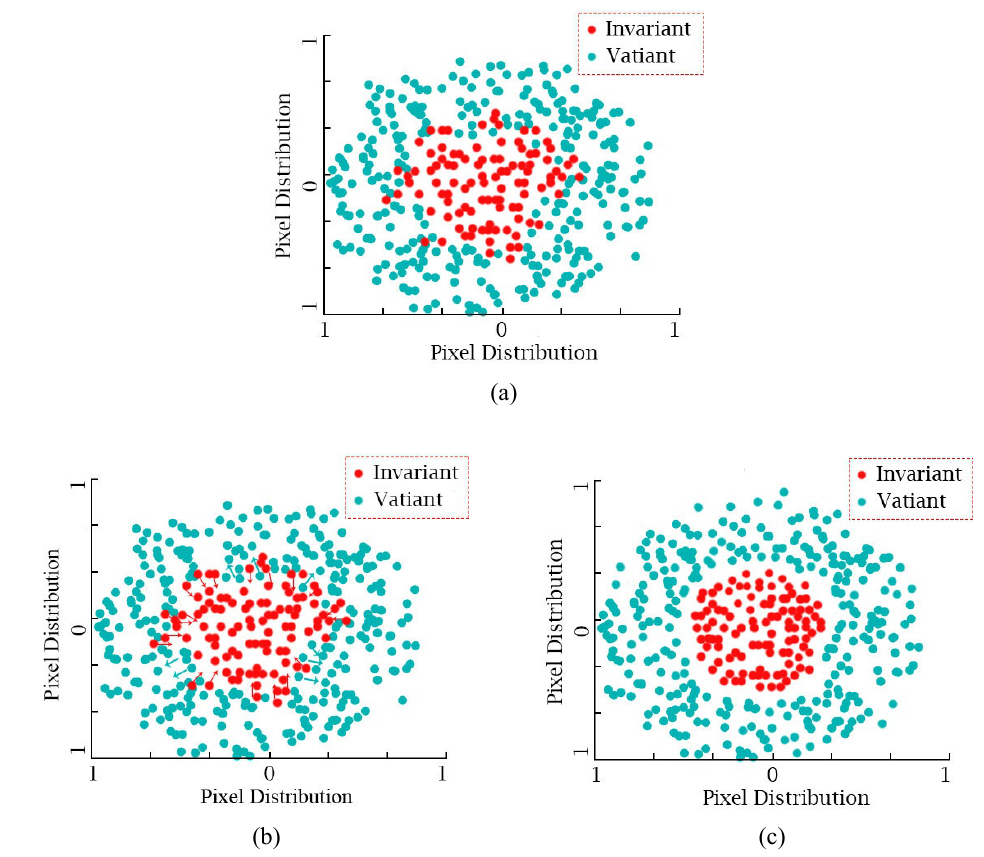
(cid:0) (cid:1) a T X , b T Y .